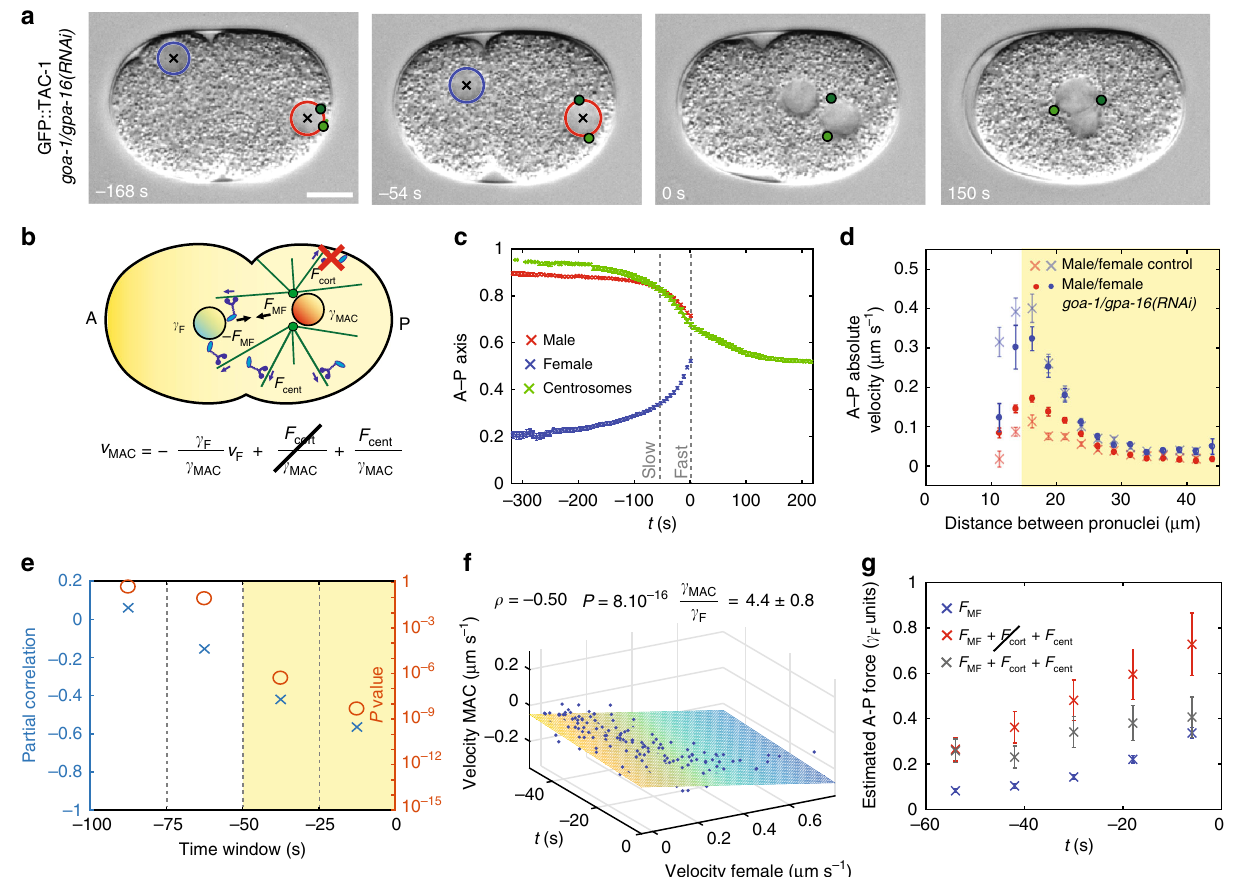
Fig. 3 Pronuclear migration and centration upon depletion of cortical forces. a , b Snapshots and schematics of pronuclei and centrosomes in goa-1/gpa-16 ( RNAi ) embryos. c Average pronuclear and centrosome midpoint positions along the A – P axis as a function of time, with S.E.M. (pronuclei: n = 31, centrosomes: n = 13). d Absolute average pronuclear velocities, with S.E.M., as a function of the distance separating them in the indicated conditions (control, n = 33, same as Fig. 1e; goa-1/gpa-16 ( RNAi ) , n = 31; here and in e , f , velocities are calculated between successive frames 6 s apart). The velocities during the acceleration phase of the female pronucleus in control and goa-1/gpa-16 ( RNAi ) embryos are compatible ( d > 15 µ m, highlighted in yellow; χ 2 = 12; P = 0.37), whereas those of the male-asters complex are not ( χ 2 = 70; P < 2 × 10 − 10 ). e Partial Pearson's correlation, controlling for time variation, between pronuclear velocities along the A – P axis over successive time windows ( n = 31). Here and in other fi gures, each time point corresponds to a time window of 25 s and the correlated time window ( P < 0.05) is highlighted in yellow (partial correlation: blue crosses; P value (Student's t test, two-sided): orange circles). f Velocity of male pronucleus as a function of time and velocity of the female pronucleus during the correlated phase of pronuclear migration in goa-1/gpa-16 ( RNAi ) embryos ( n = 31, − 50 < t < 0 s time window). Plane: linear fi t (cid:1) (cid:3) v MAC ¼ (cid:2) γ F γ v F þ v 0 þ mt v 0 ¼ (cid:2) 0 : 10 ± 0 : 01 ð Þ μ ms (cid:2) 1 ; m ¼ (cid:2) 0 : 0008 ± 0 : 0003 ð Þ μ ms (cid:2) 2 ; errorsareS : D : . Here and in Fig. 4f, the Pearson ’ s partial MAC correlation coef fi cient ρ between the velocities of the male-aster complex (or asters pair) and female pronucleus, controlling for time variation, its P value (Student ’ s t test, two-sided) and the fi tted ratio between the drag coef fi cients of the male-asters complex (or asters pair) and female pronucleus are indicated. g Estimated A – P forces (with S.E.M.) acting on the male-asters complex and female pronucleus shortly before their meeting. Blue: force between pronuclei ( n = 31). Red: sum of forces acting between pronuclei and centering force ( n = 31). Gray: total force acting on male-asters complex in control embryos ( n = 33). Here and in Fig. 4g, force is expressed in units of the drag of the female pronucleus, estimated to be ~130 pN s μ m − 1